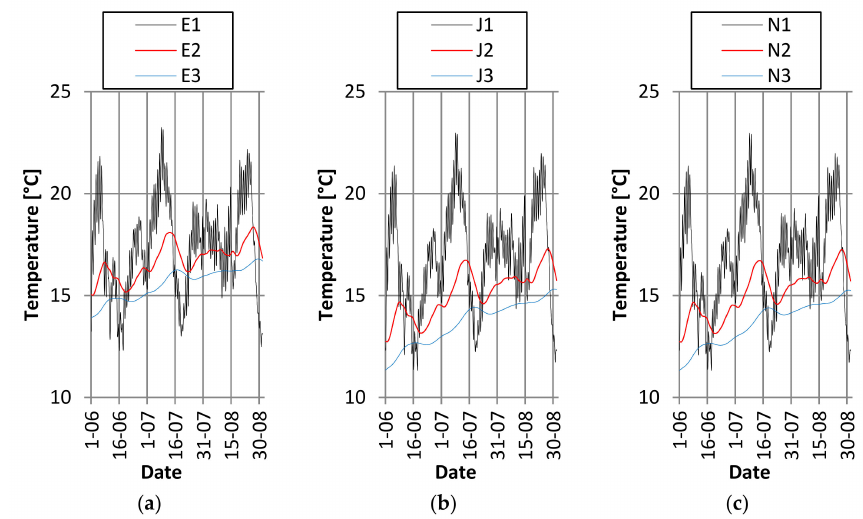
Figure 3. Soil temperature in lines E, J, and N on selected days during the summer